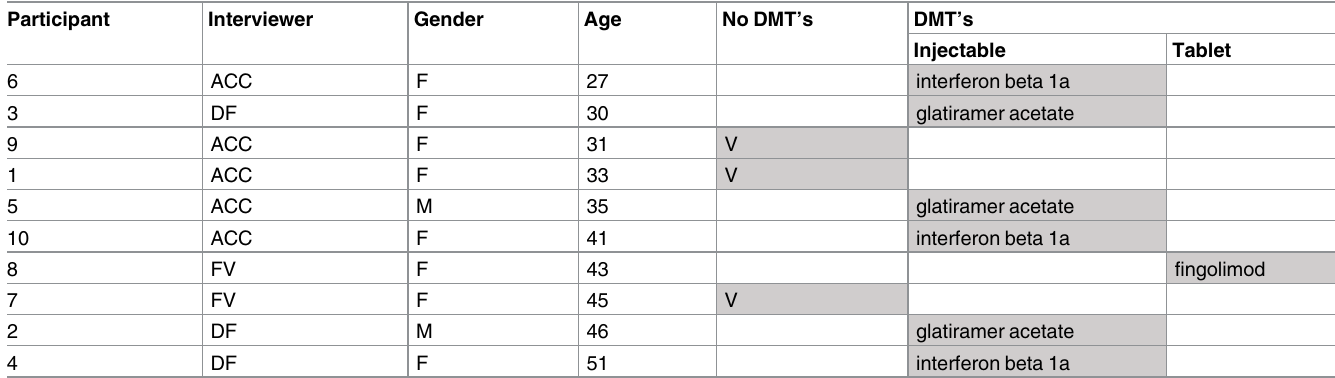
Table 1. Profile of the